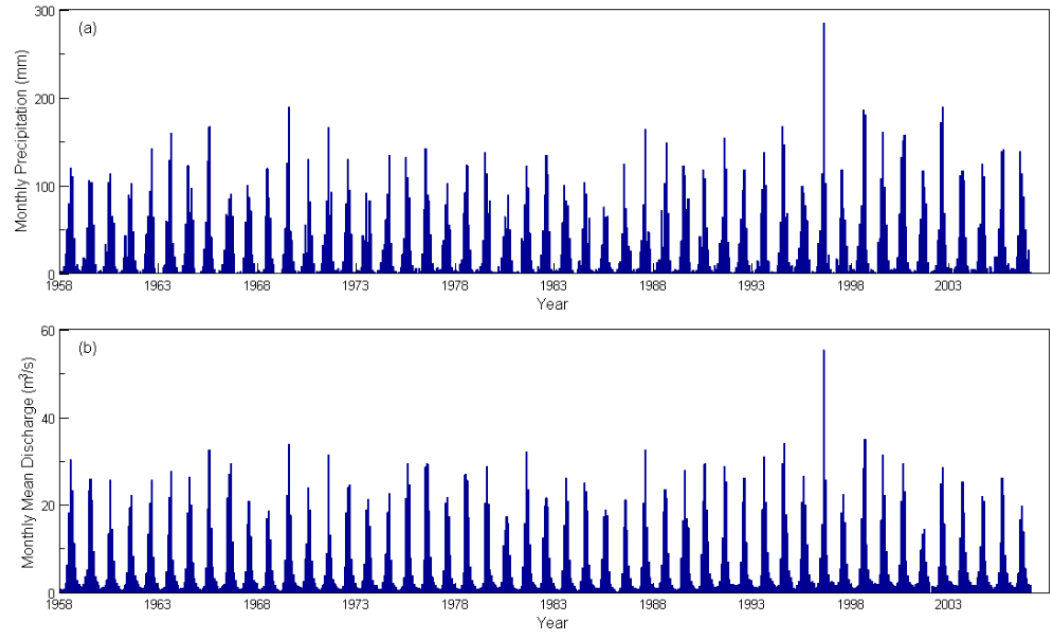
Figure 2. The monthly average precipitation and discharge series of Urumqi River from 1958 to 2006. The panel ( a ) is the precipitation sequence and panel ( b ) is the discharge sequence.